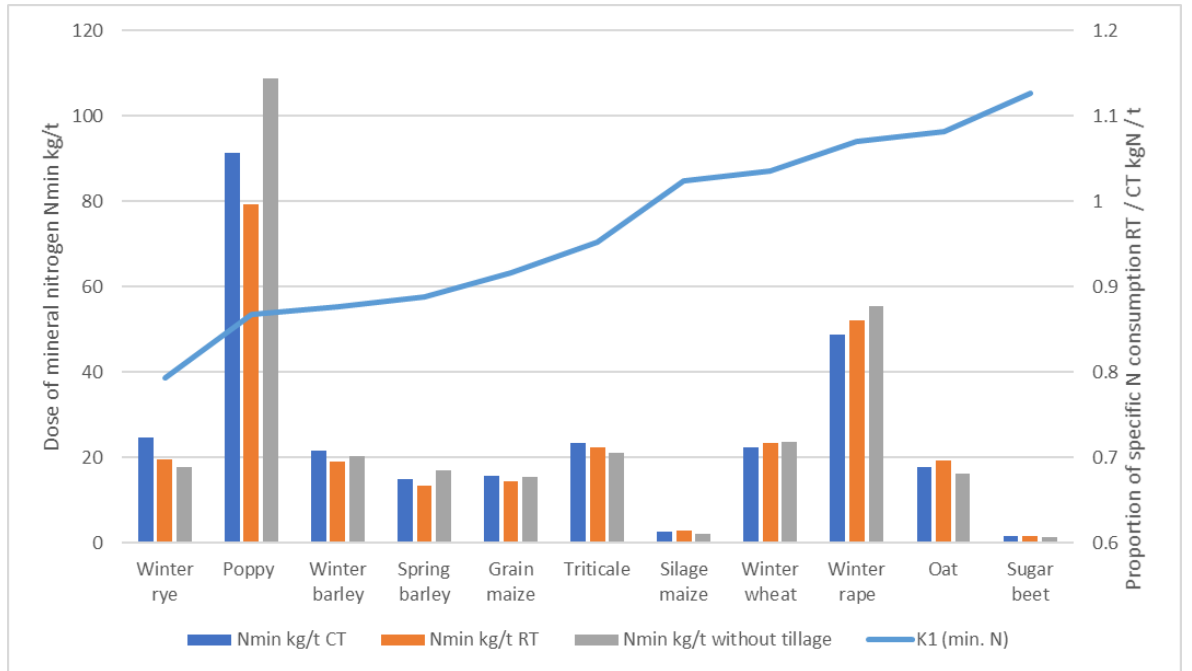
Figure 3. The change of specific consumption of nitrogen in crops.